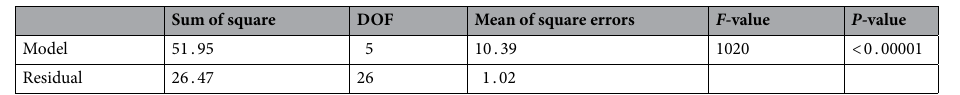
Table 4. ANOVA analysis of variance to determine oil recovery factor in water flooding.